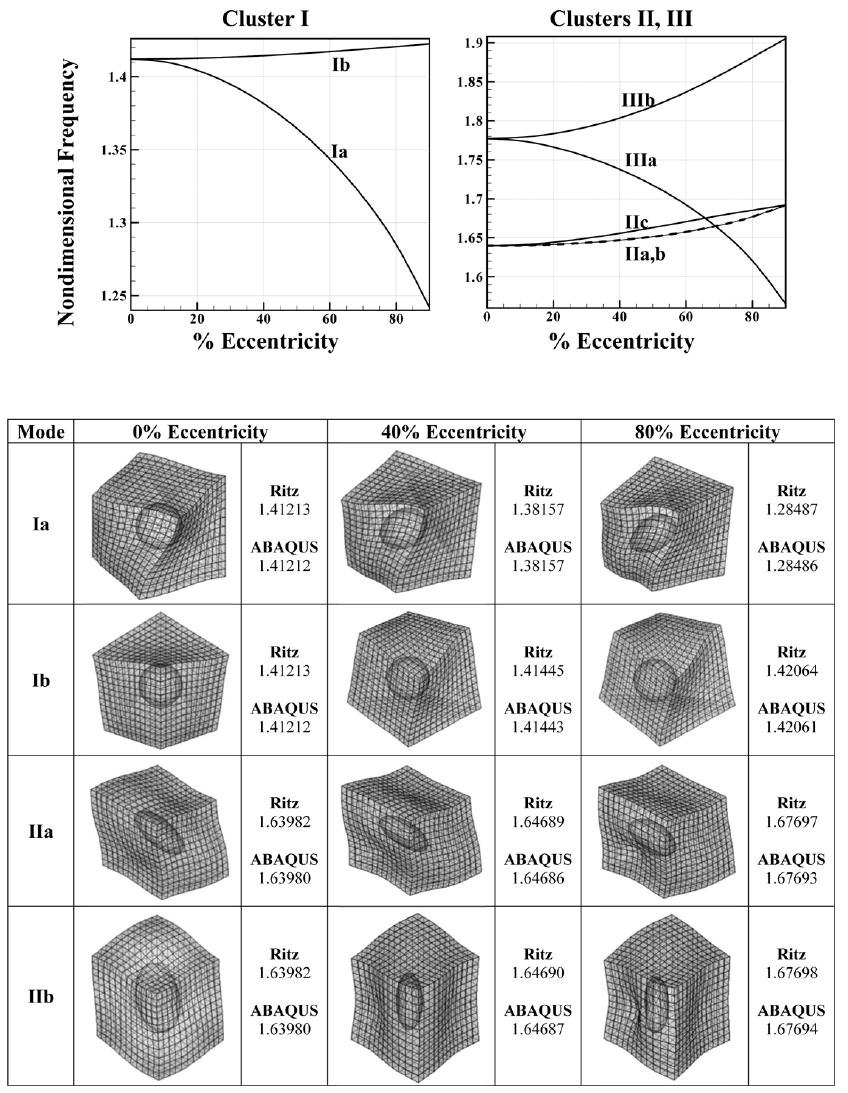
Fig. 4. Variation of the fi rst three frequency clusters with eccentricity parameter for the solid parallelepiped with an internal spherical cavity, along with the fi rst four three-dimensional mode shapes for selected eccentricity parameters. The modal spectrums of elastic solids exhibit very unique characteristics. In the absence of eccentricity (¯ e = 0) , due to the presence of geometricsymmetries, perfectlyrepeatedfullydegenerate(multiplet)frequenciesare observed. For example, one may consider the fi rst frequency cluster (i.e., cluster I) associated with the spheroidal modes for the concentric elastic sphere (i.e., see the fi rst column of Fig. 6; also see [1]), for which there is a total of fi ve fully degenerate frequencies (note that only the fi rst four mode shapes correspondingto sub-clusters Ia,b,c,d are displayed, due to the space limit). Similarly, multiple degeneracies are observed for clusters II and III in Fig. 2, cluster I in Fig. 3, clusters II and III in Fig. 4, clusters I and II in Fig. 5, and clusters I and II in Fig. 6. Also, a more careful examination of mode shapes presented in the fi rst column of each fi gure demonstrates that, due to problem symmetry, certain mode shapes associated with the degenerate frequency clusters occur in pairs (i.e., they are exactly the same, but merely rotated). In particular, the degenerate mode pairs IIa,b and IIIa,b are observed in Fig. 2, modes Ia,b in Fig. 3, modes Ia,b, IIa,b and IIIa,b in Fig. 4, modesIa,b and IIa,b in Fig. 5, and modes Ia,b, Ic,d, IIa,b, and IIc,d in Fig.